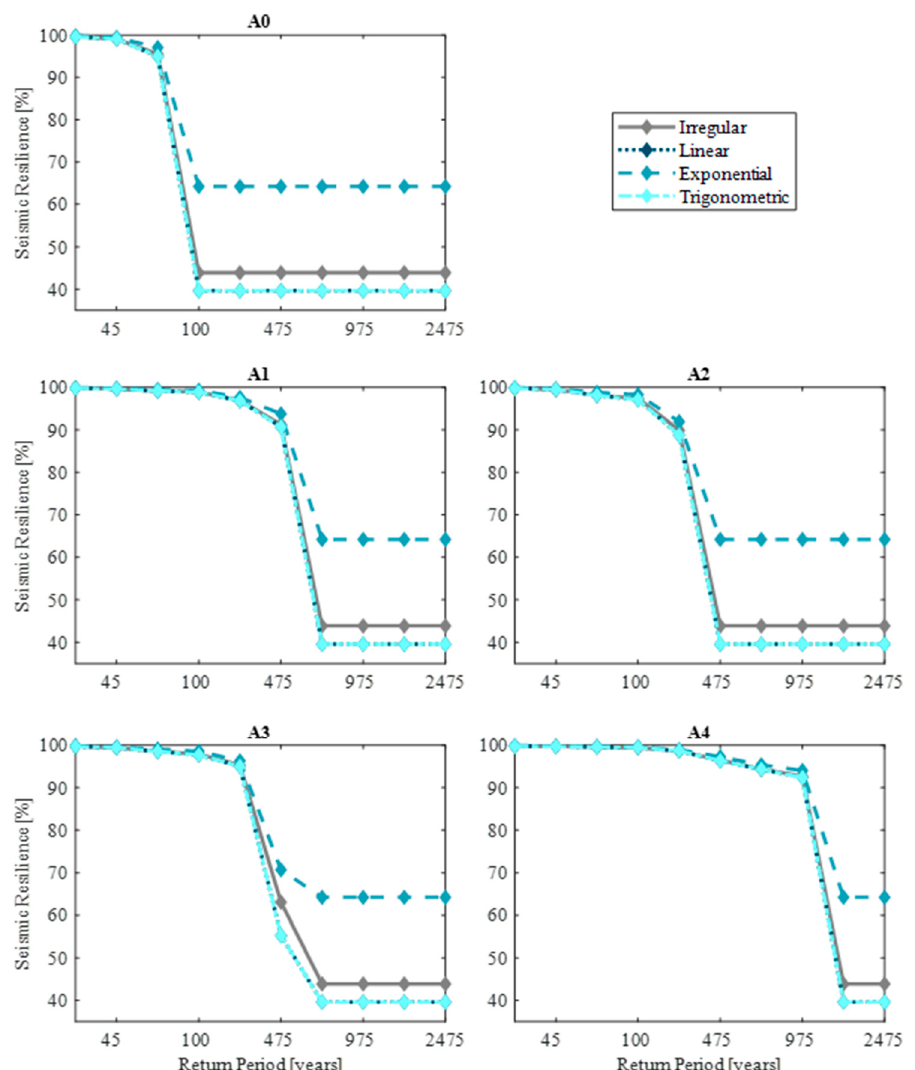
Figure 14. Seismic resilience index for a wide range of intensities using different recovery functions.